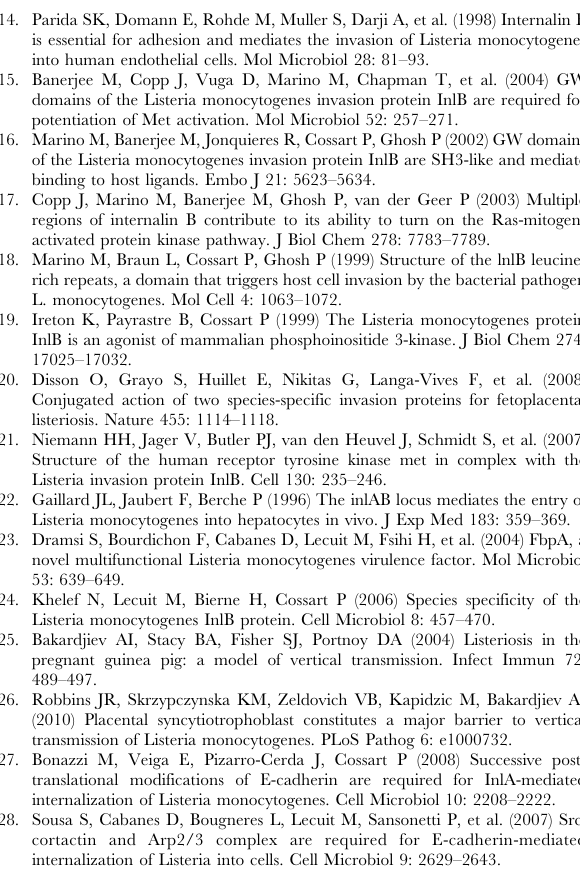
indicated. Arrows indicate intracellular puncta of E-cadherin.